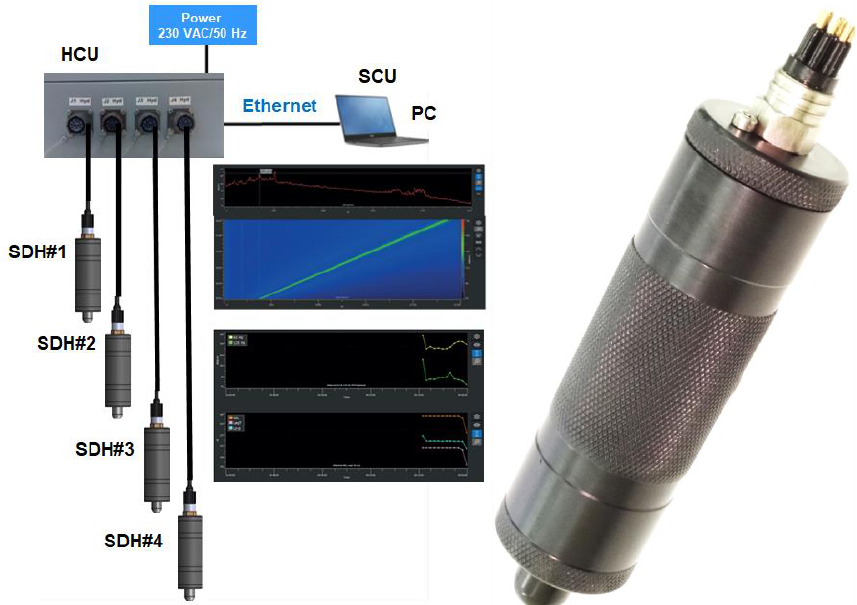
Figure 3. General architecture of the SDH system ( left ) and smart digital hydrophone ( right ). Image property of Sociedad Anónima de Electronica Submarina S.M.E. (SAES). The hydrophones were calibrated according to the IEC 60565 [17] and the accelerome- ters according to IEC 16063